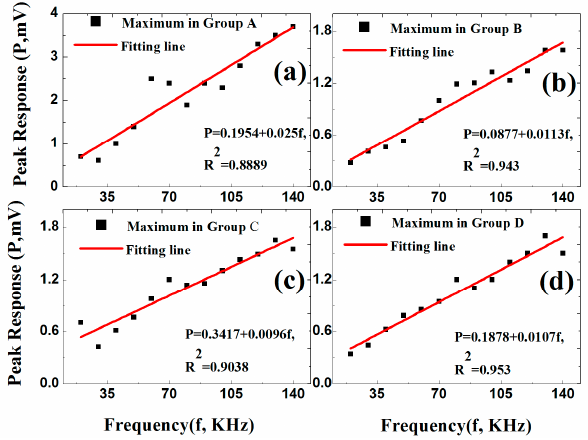
Figure 9. Peak response at each frequency in ( a ) Group A; ( b ) Group B; ( c ) Group C, and ( d ) Group D. The lines are linear fits and the expressions show fitting results.